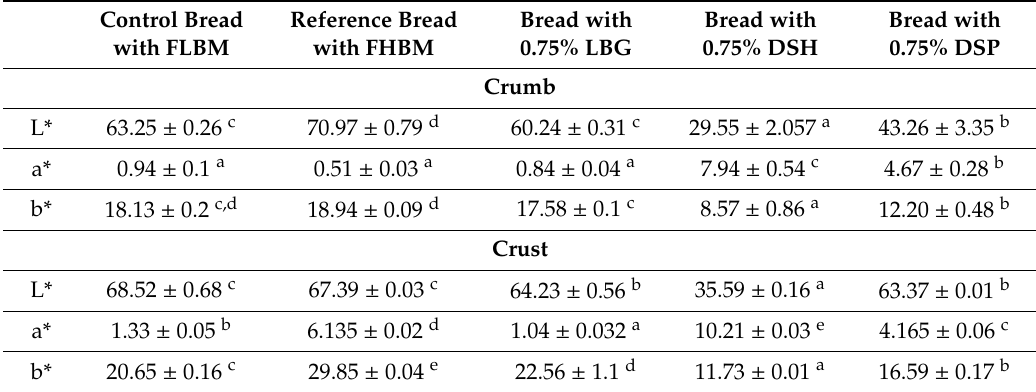
Table 5. The e ff ect of DSP and DSH addition on the color characteristics of